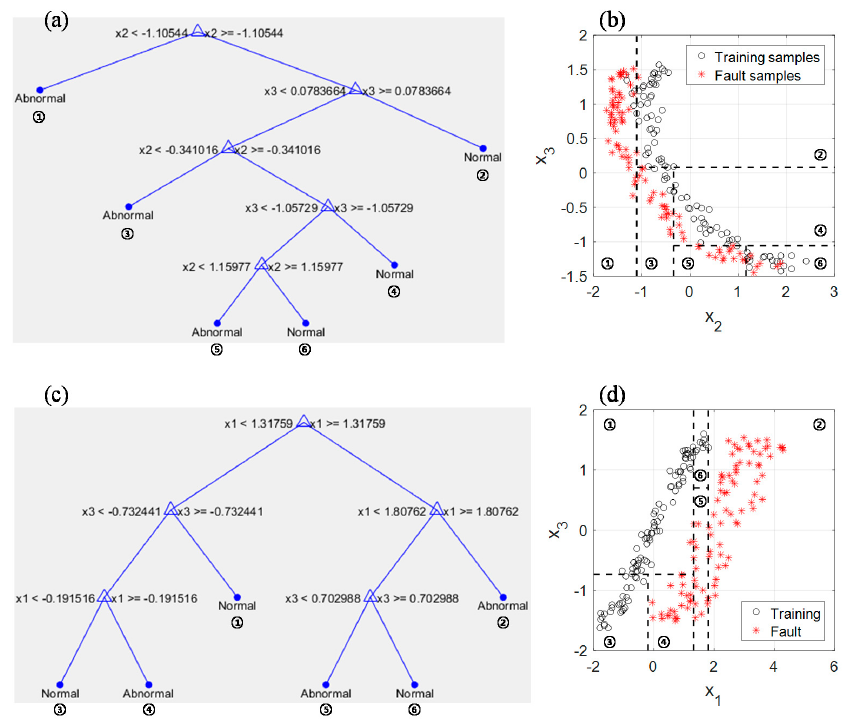
Figure 6. (Nonlinear process) Constructed tree for variable ranking in Figure 5 and relevant scatter plots for normal and faulty samples: ( a ) (Case 1) final tree; ( b ) (Case 1) scatter plot for 100 normal samples and faulty samples (from t fault start = 201 to t fault = 300); ( c ) (Case 2) final tree; ( d ) (Case 2) scatter end plot for 100 normal samples and faulty samples (from t fault start = 171 to t fault = end